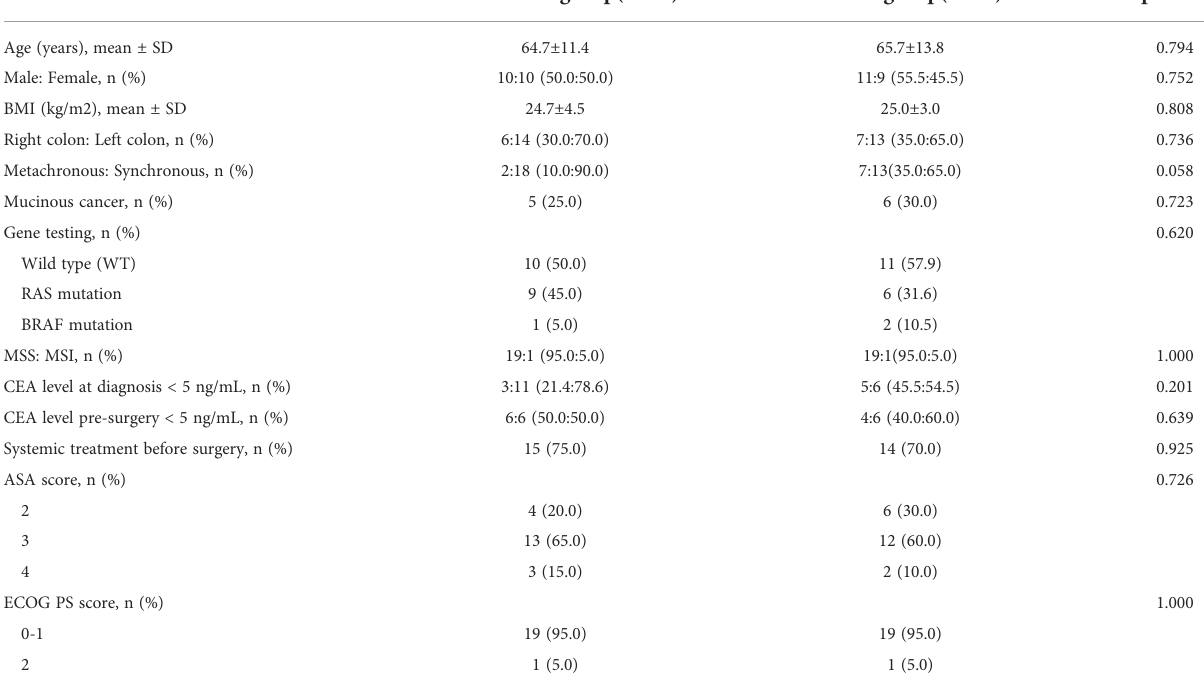
TABLE 1 Pre-operative